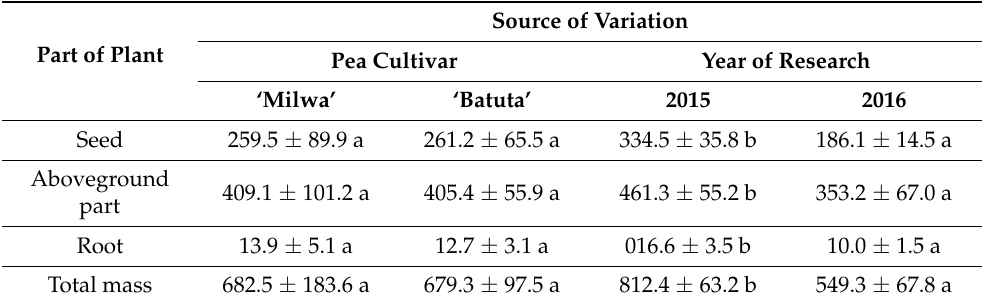
Table 5. Dry weight of pea plants at BBCH stage 90, g · m − 2 (means for cultivars and for years of research from three replications ±